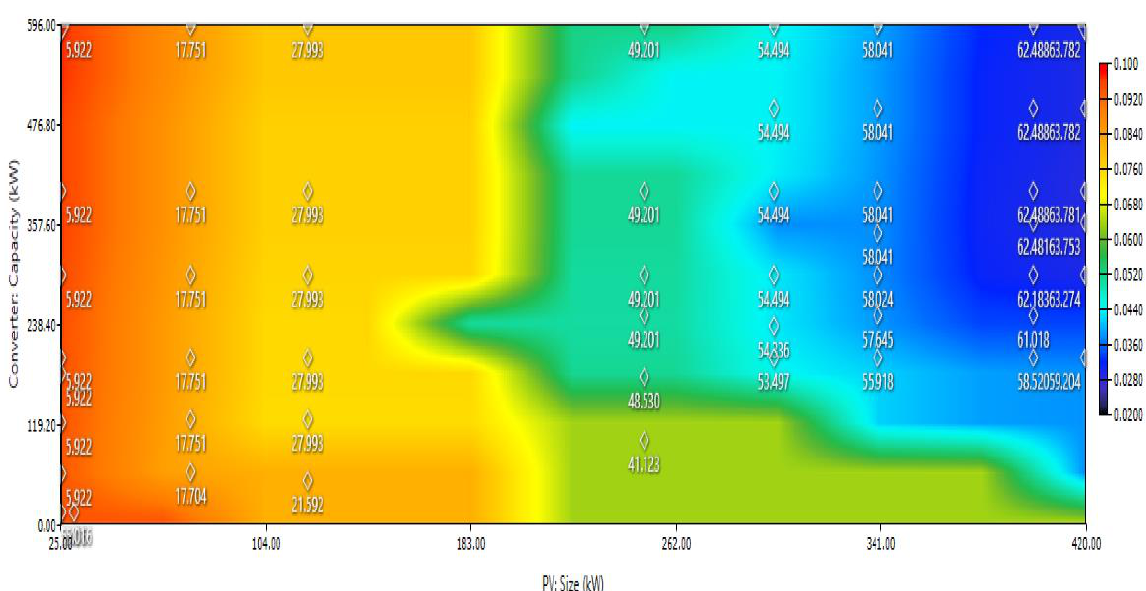
Figure 18. Inflation effects on COE and NPC.